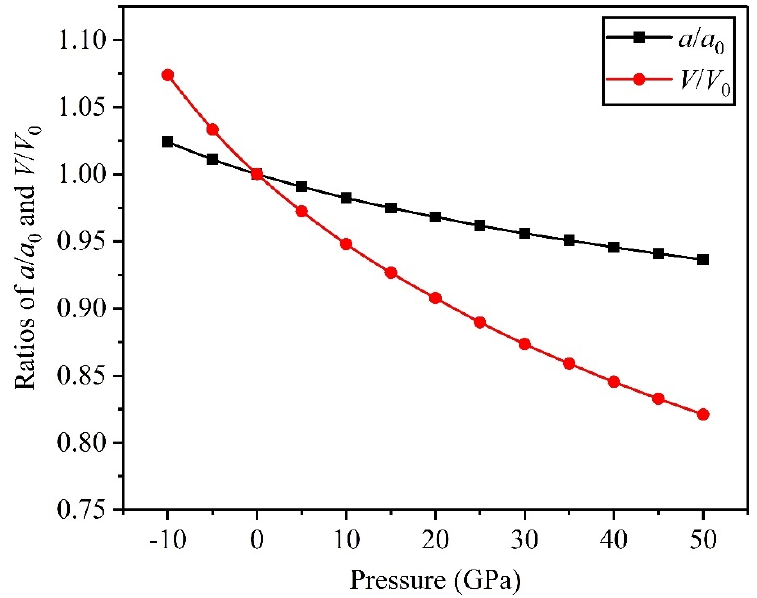
ff erent pressures for the NiTi / V V and / a a under different pressures for the NiTi SMA. Figure 3. Variation curves of the ratios V / V 0 and a / a 0 under di 0 0